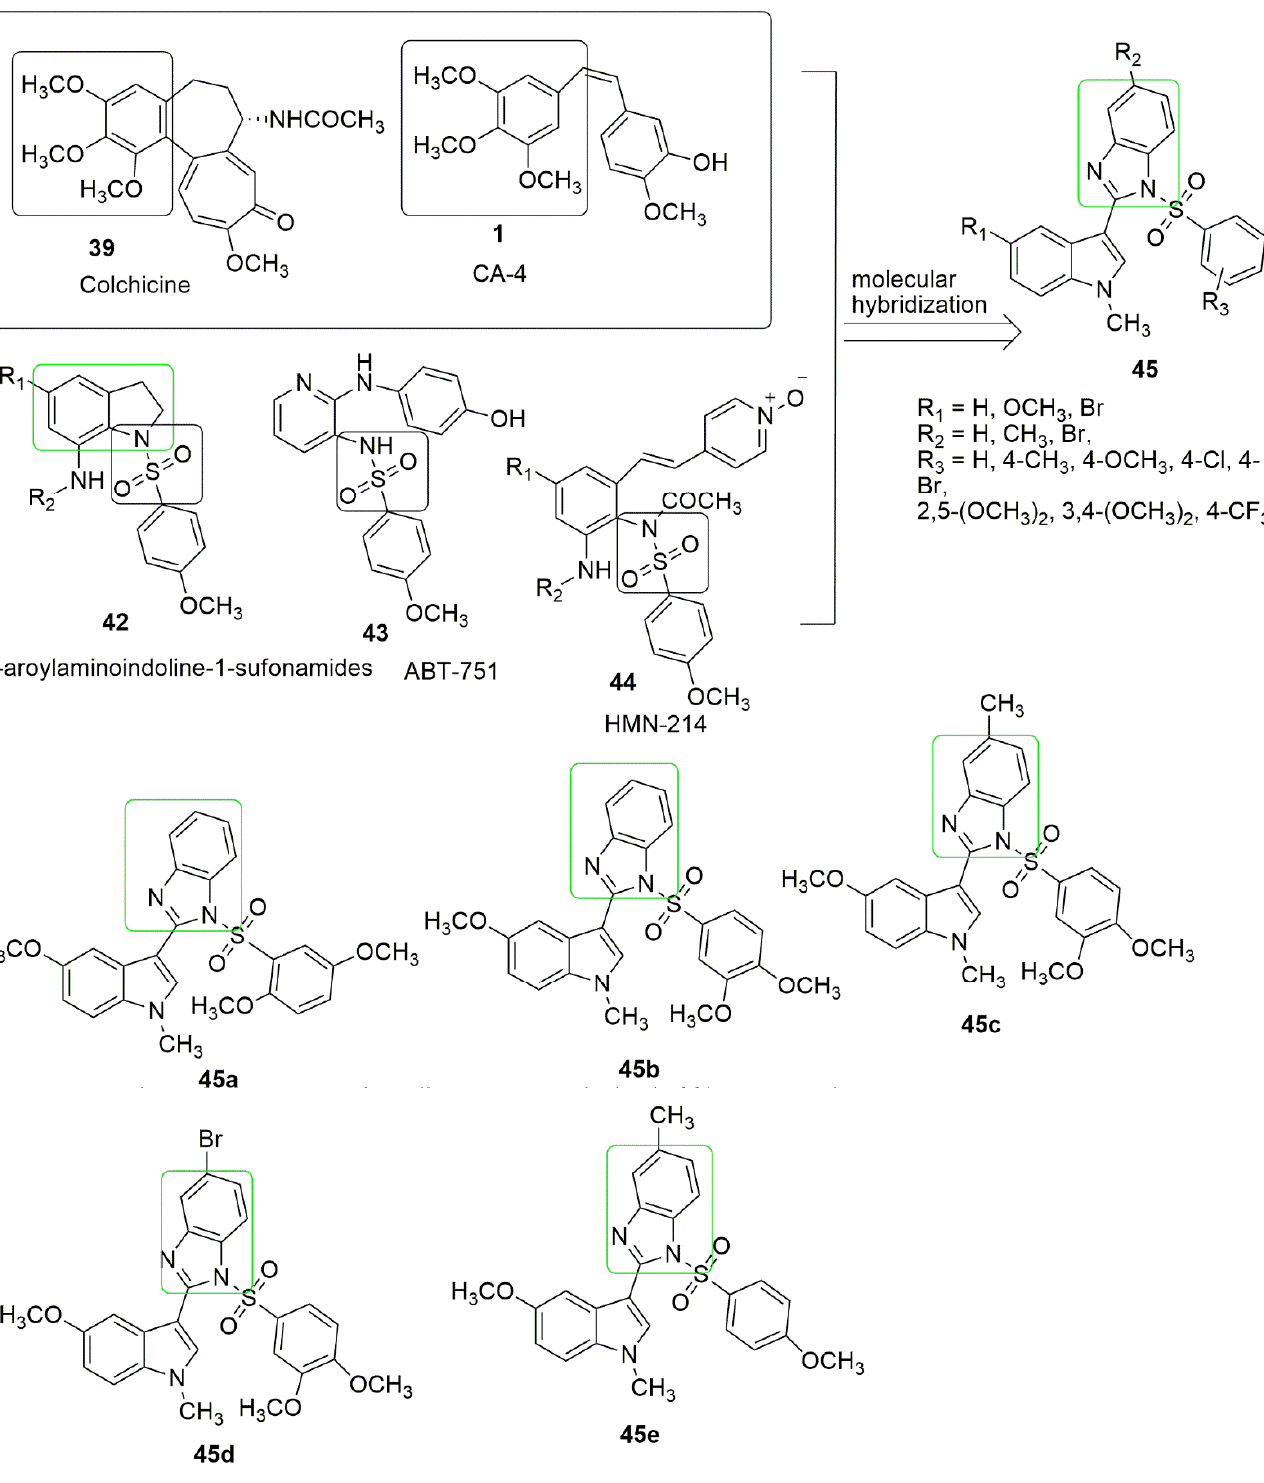
Figure 15. Active anti-cancer compounds of 1-phenylsulphonyl-2-(1-methylindol-3-yl)-benzimidazole derivatives. Table 1. Antiproliferative and anti-tubulin inhibition values of compounds 21a-e, combretastatin A- 4, and colchicine.